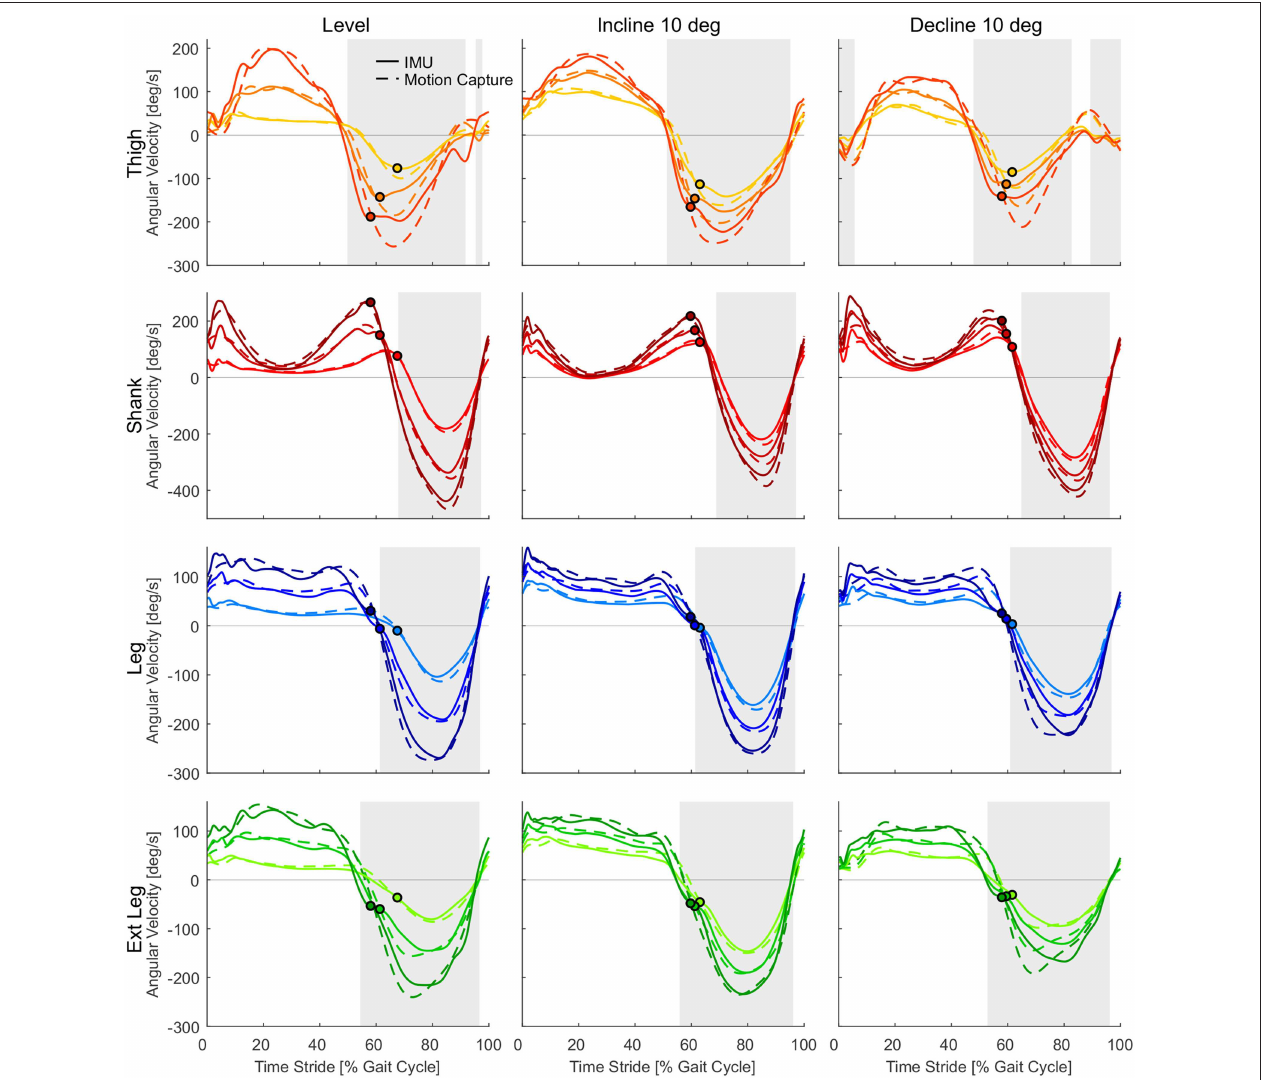
FIGURE 5 | Angular velocities from inertial measurement units (solid) and motion capture (dashed) for the thigh (orange), shank (red), leg (blue), and extended leg segment (green) in level walking, inclined walking (10 ◦ ) and declined walking (10 ◦ ). Darker colors indicate higher speeds (0.9, 1.3, and 1.7m/s for slopes, 0.5, 1.3, and 2.1m/s for level walking). Circles indicate the related toe-off determined by the vertical ground reaction force. The heel-strike and the following heel-strike of the same limb occur at 0 and 100% of the stride time. Gray areas indicate the swing phase based on the angular velocity of the IMU at